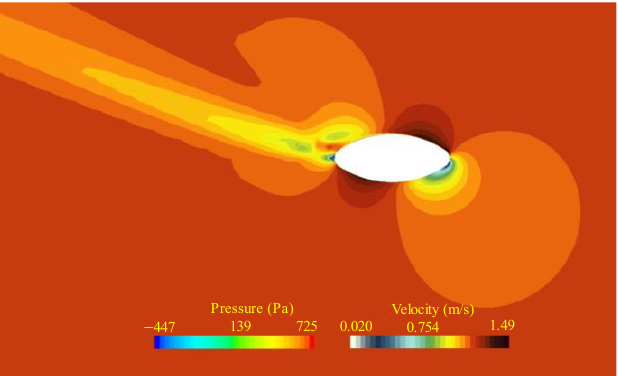
Figure 5. Velocity and pressure around the platform in heaven motion. Figure 4. Velocity around the platform along the current.